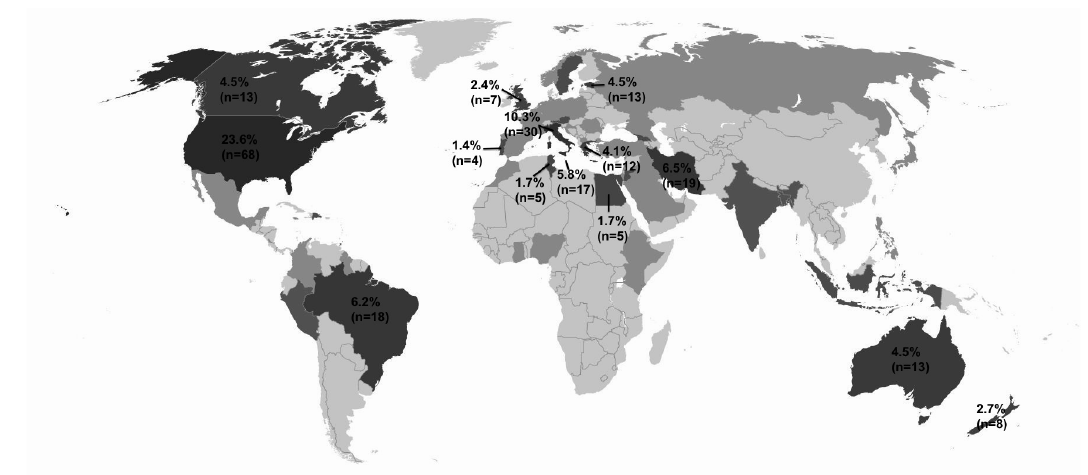
Figure 1. Percentages of Participants from the Top 14 Most Represented Countries.